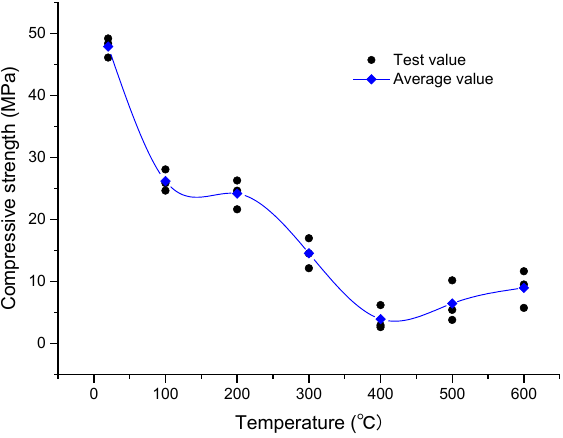
Figure 9. Variation in the compressive strength of oil shale with increasing temperature. Phase I (20–400 °C): In this phase, the compressive strength decreases considerably with increasing temperature. The compressive strength of oil shale at room temperature is 47.9 MPa. At temperatures of 100 and 200 °C, the compressive strength decreases to 26.22 and 24.21 MPa, respectively; thus, at these temperatures, the compressive strength of oil shale is less than half of its compressive strength at room temperature. During the heating process, the large fractures will first expand along the bedding, thus decreasing the cohesion between the internal matrix of the oil shale and different bedding planes; this induces a rapid decrease in the compressive strength. When the temperature increases from 200 to 400 °C, the compressive strength decreases to 3.97 MPa. In this temperature range, kerogen transforms from a solid to a liquid form and then decomposes into asphal- tene. Oil shale has a certain number of open pores and fractures; this structure permits asphaltene to migrate and fill the existing fractures. However, asphaltene will decompose into shale oil and mixed hydrocarbon gas, which will increase the internal pressure of pores and promote the rapid expansion of pore-fracture structures. Overall, it shows the damage to the mechanical strength of the rock . Phase II (400–600 °C): In this phase, the compressive strength increases slowly with temperature. The compressive strength increases to 9.0 MPa at 600 °C. At this tempera- ture, the pyrolysis of oil shale is largely complete. Kaolinite loses its crystal water and turns into metakaolinite [26,27] at 520–540 °C, which increases the compressive strength. 3.4. Evolution of Oil Shale Permeability with Increasing Temperatures Figure 10 shows the influence of the pyrolysis temperature on the oil shale permea- bility. At 100–200 °C, the oil shale permeability is in the order of 10 −3 md. When the tem- perature is in the range 300–400 °C, the permeability of oil shale is in the order of 10 −2 md. When the temperature exceeds 500 °C, the permeability of oil shale is found to be large. The process of the change can be divided into three stages, according to the rate of change of the permeability with temperature.